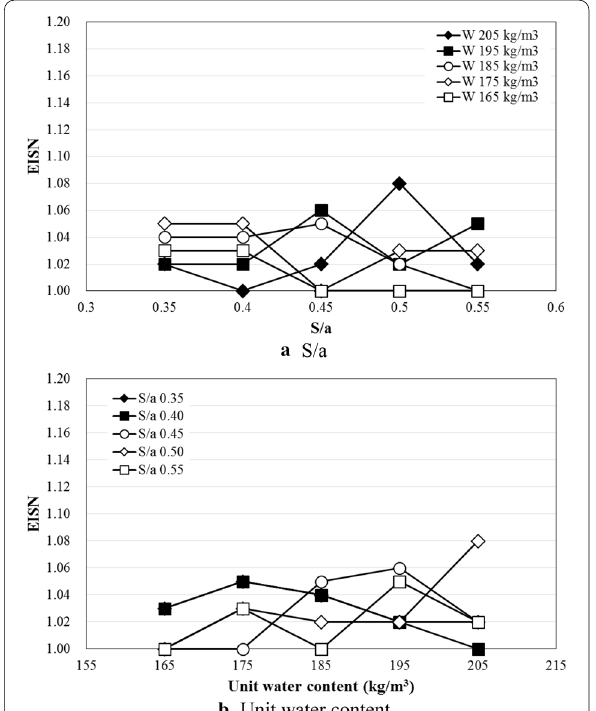
Fig. 14 Effects of S/a and unit water content on EISN of high‑strength concrete mixtures.